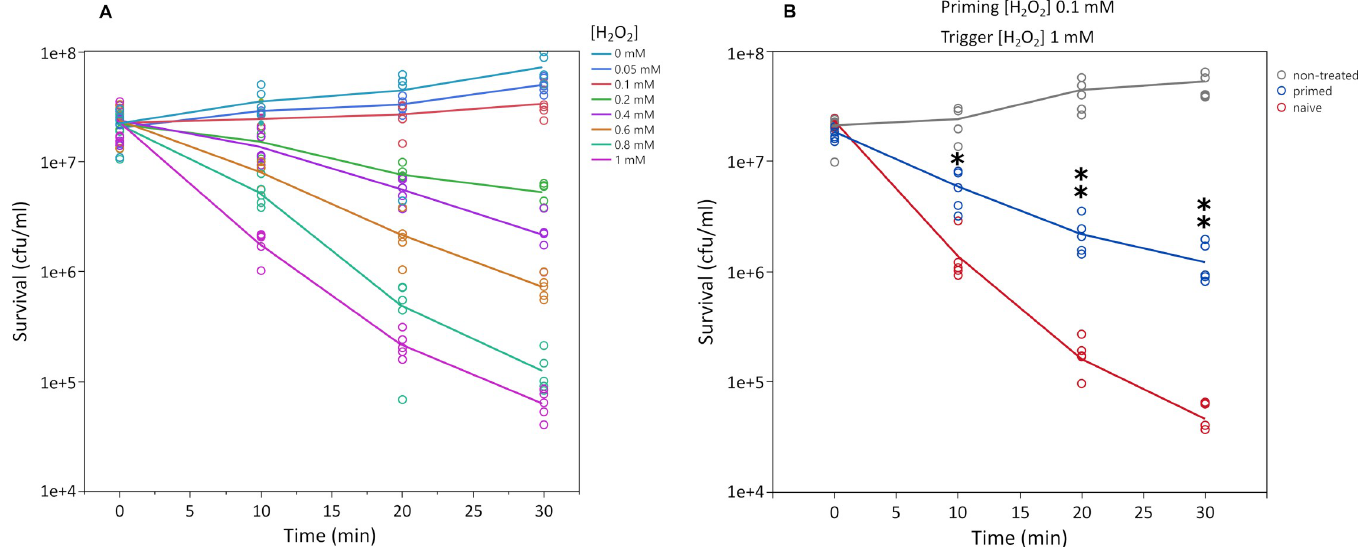
Fig 1. Hydrogen peroxide killing curves of E . coli MG1655. Panel A shows bacterial sensitivity to 1 mM H 2 O 2 with a strong dose-response effect ( p = 2.1x10 -16 , DRC model fitted based on maximum likelihood). Panel B shows the priming effect or improved response when cells are treated in advance with a non-lethal dose (0.1 mM). Curves represent the mean of five independent cultures per time point. Asterisks represent significant differences (Welch’s test, one asterisk for p < 0.05 and two asterisks for p < 0.01). Only comparisons between primed and non-primed groups are shown.